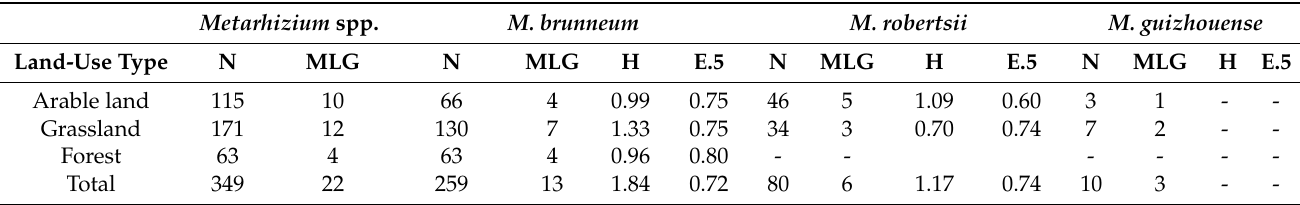
Table 2. Numbers of isolates, multilocus genotypes, and genotype diversity among the three Metarhizium species— M. brunneum , M. robertsii , and M. guizhouense —for three different LUTs: arable land, grassland, and forest. Metarhizium spp.